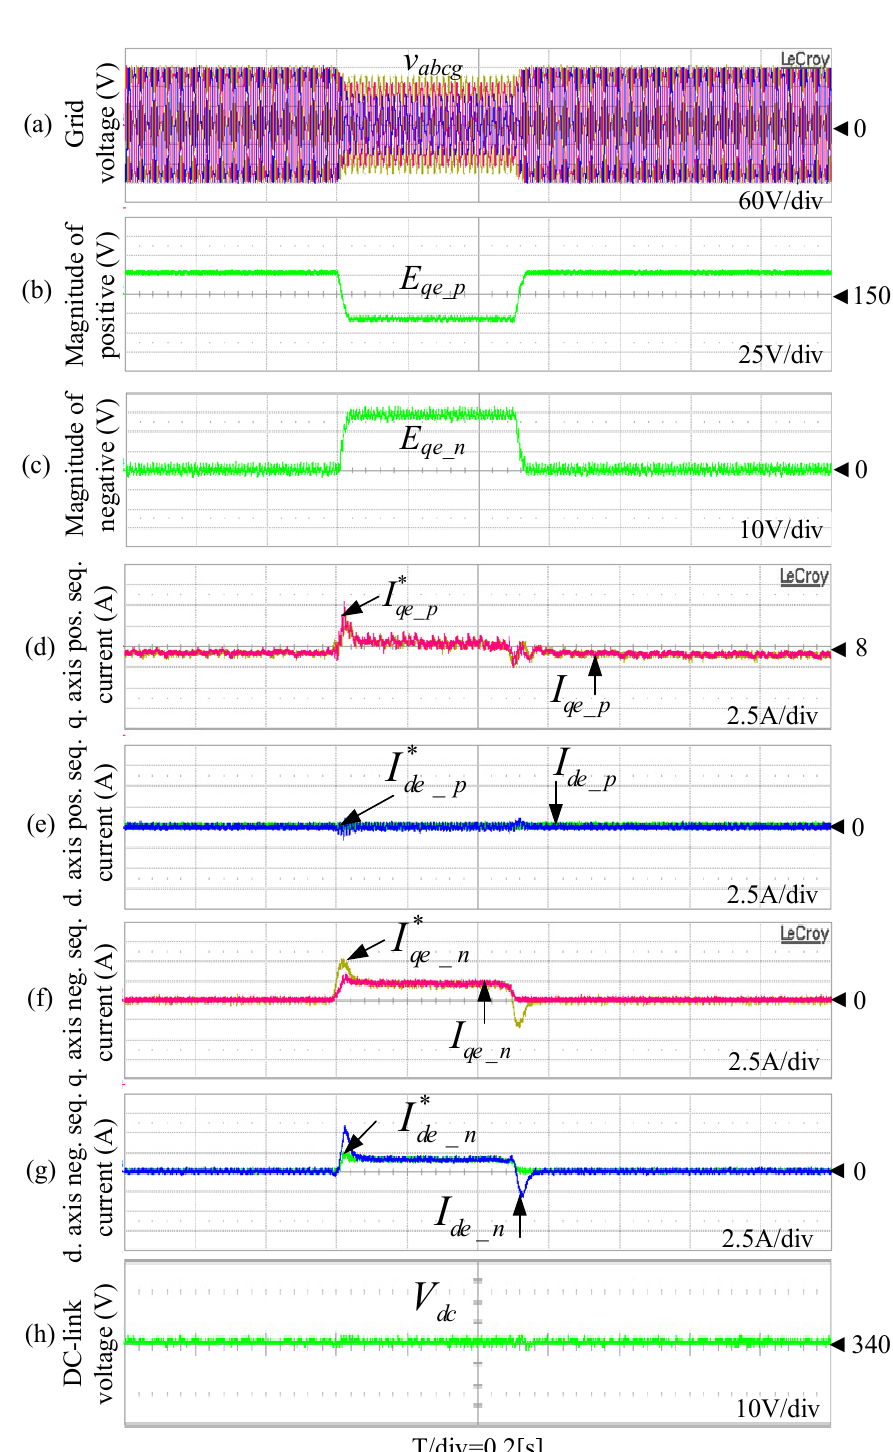
Figure 10. Performance of the grid-side converter at unbalanced voltage dip. ( a ) Grid phase voltages. ( b ) The magnitude of PSC. ( c ) The magnitude of NSC. ( d ) q-axis currents of PSC. ( e ) d-axis currents of PSC. ( f ) q-axis currents of NSC. ( g ) d-axis currents of NSC. ( h ) The DC-link voltage of B2B converters.